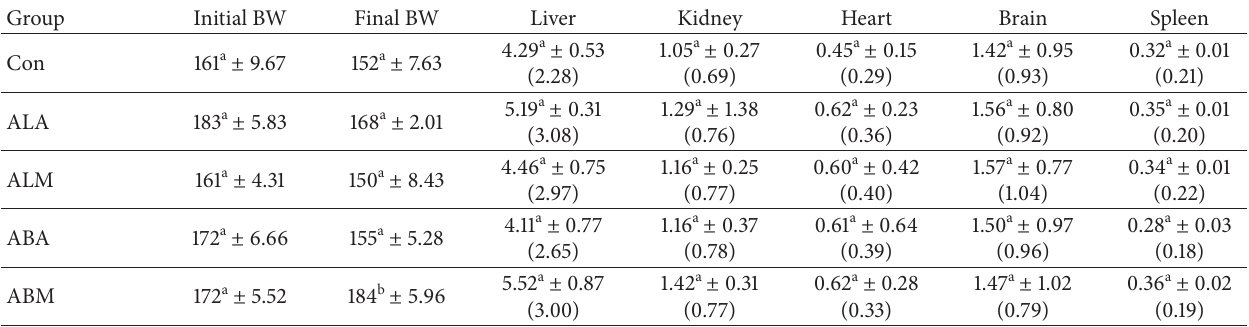
Table 2: Relative body (BW) and organ weights of control and experimental groups (g) (values in parenthesis indicate organ-BW ratio) (𝑛 = 6) . Group